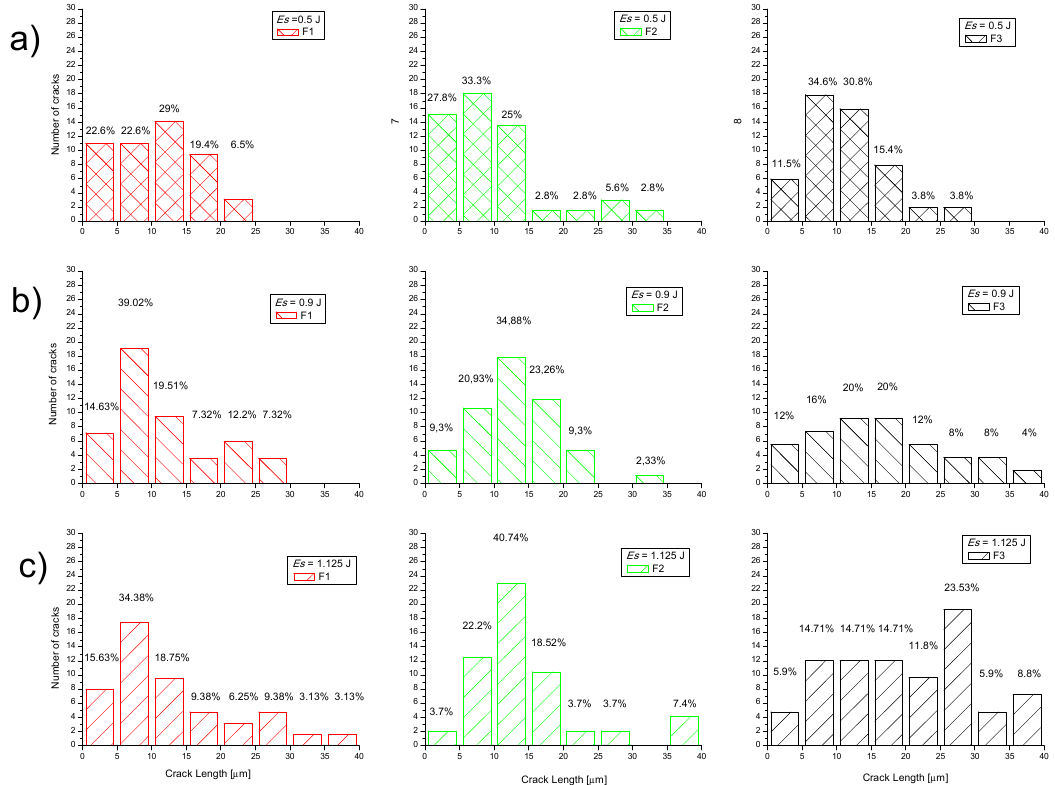
Figure 17. Number of cracks vs. cracks length of multiple-layer deposition produced using: ( a ) 0.5 J (V1, C2, 10 L/min), ( b ) 0.9 J (V2, C1, 10 L/min) and ( c ) 1.125 J (V2, C1, 10 L/min) as a function of the frequency (F1 < F2 < F3).